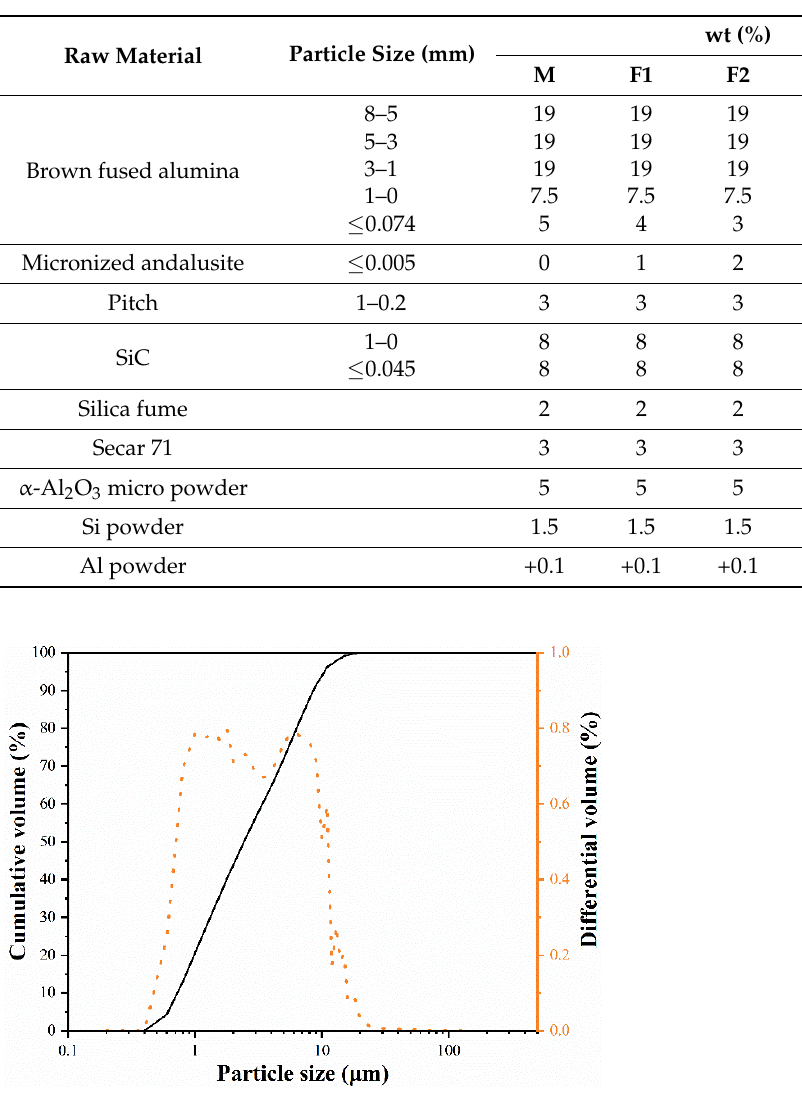
Figure 1. Particle size distribution of micronized andalusite. Table 1. M ass fractions (wt%) and particle sizes (mm) of raw materials in Al 2 O 3 -SiC-C (ASC ) castables.